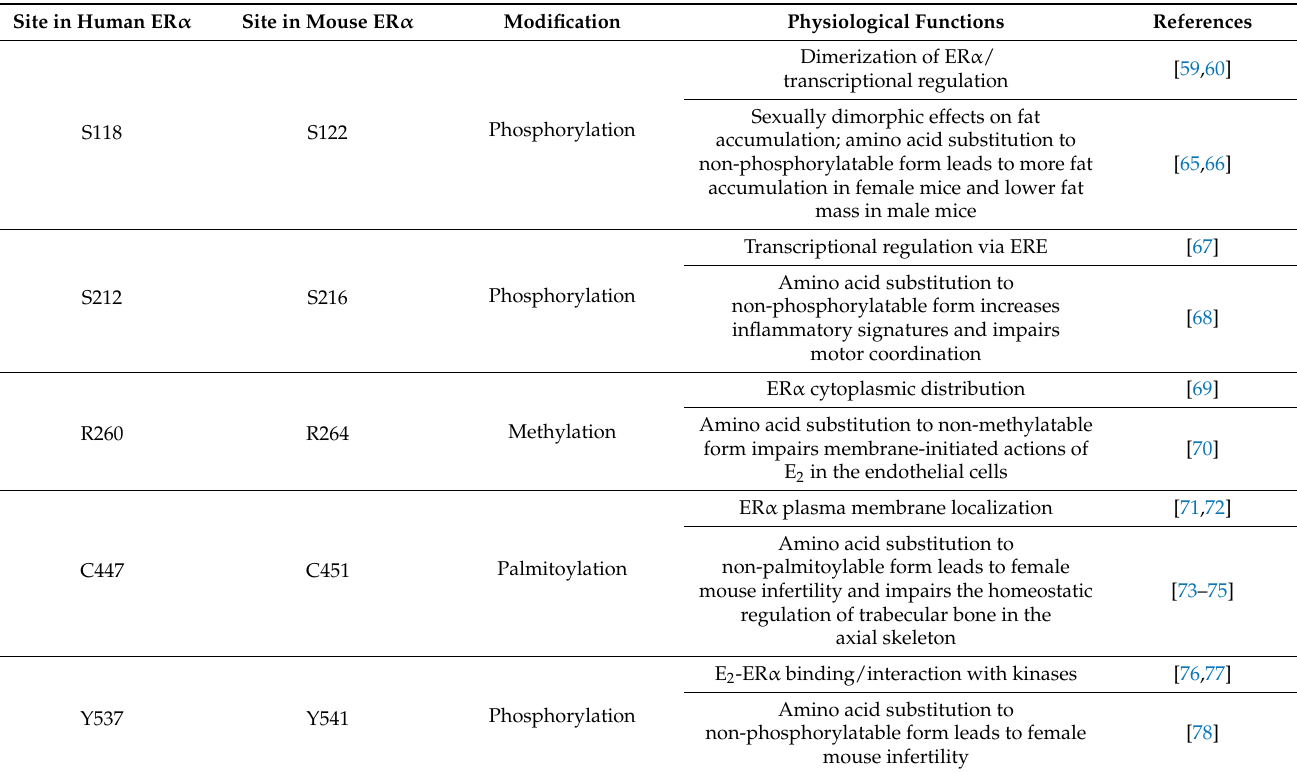
Table 2. Post-translational modifications of ER α and the physiological